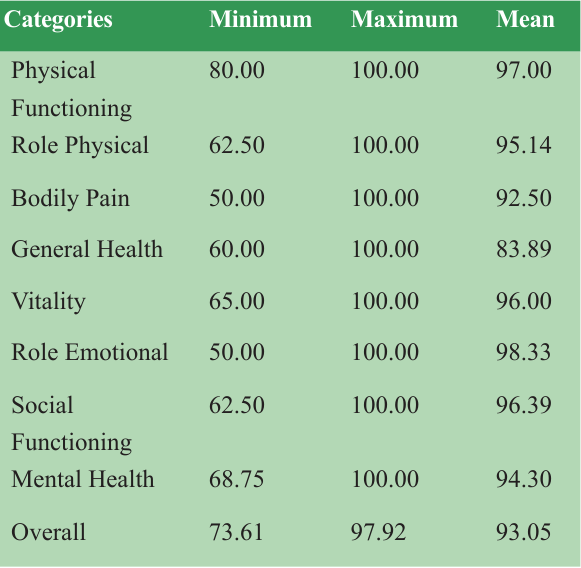
Table 2: SF 36 QOL scores after donor nephrectomy